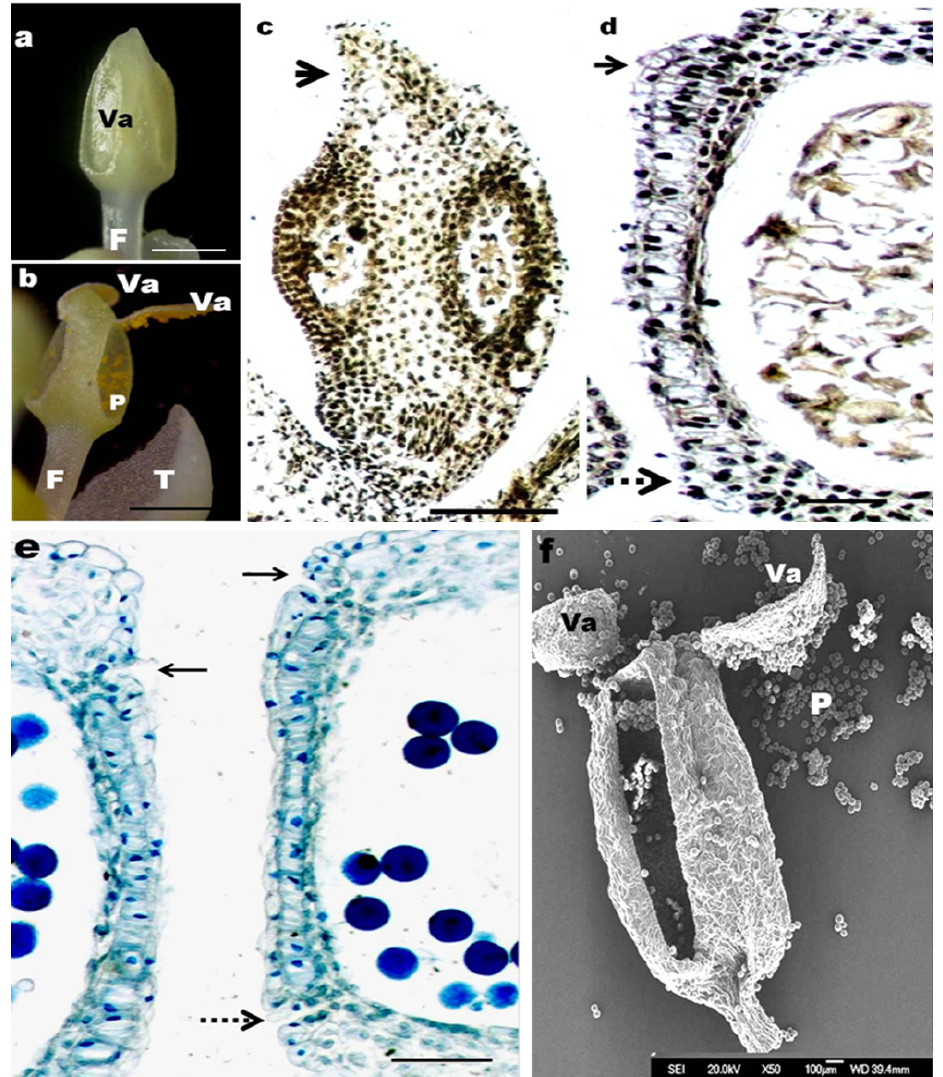
Fig. 8. a. Stereomicrograph of an anther before dehiscence, Bar 0.5mm ; b. Stereomicrograph of an anther dehis- cence by means of valve and yellow pollen grains in pollen sac, Bar 0.5 mm ; c. Longitudinal section of a young anther with valve and appandage (→), Bar 100 μm ; d. The endothecium at the upper (→) and lower region (--->) of the valves of mature anther, Bar 100 μm ; e. Anther valves near to dehiscence, stained with Coomassie brilliant blue, Bar 100 μm ; f. Scanning electron micrographs of anther dehiscence.Va-Valve; P-Pollen;